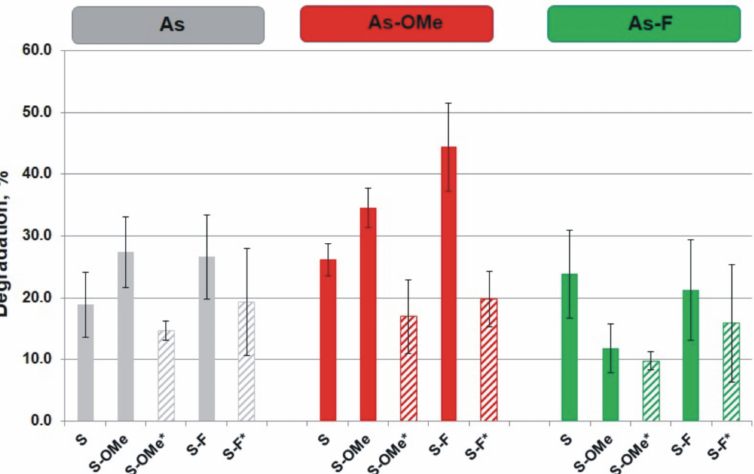
Figure 3. Degradation of the siRNA desorbed from AuNPs in FBS. siRNAs are categorized according to the type of their antisense strand. Boxes in the upper row show the category of the antisense strand (As) of an siRNA. For clarity of presentation of different categories of siRNAs, different colors are used. Colored vertical columns represent the data for each member of a category (each siRNA). Striped columns denote PG-modified siRNAs, and an asterisk (*) in an siRNA name indicates the PG-modified strand. Mean values ( ± SD) from at least four independent experiments are